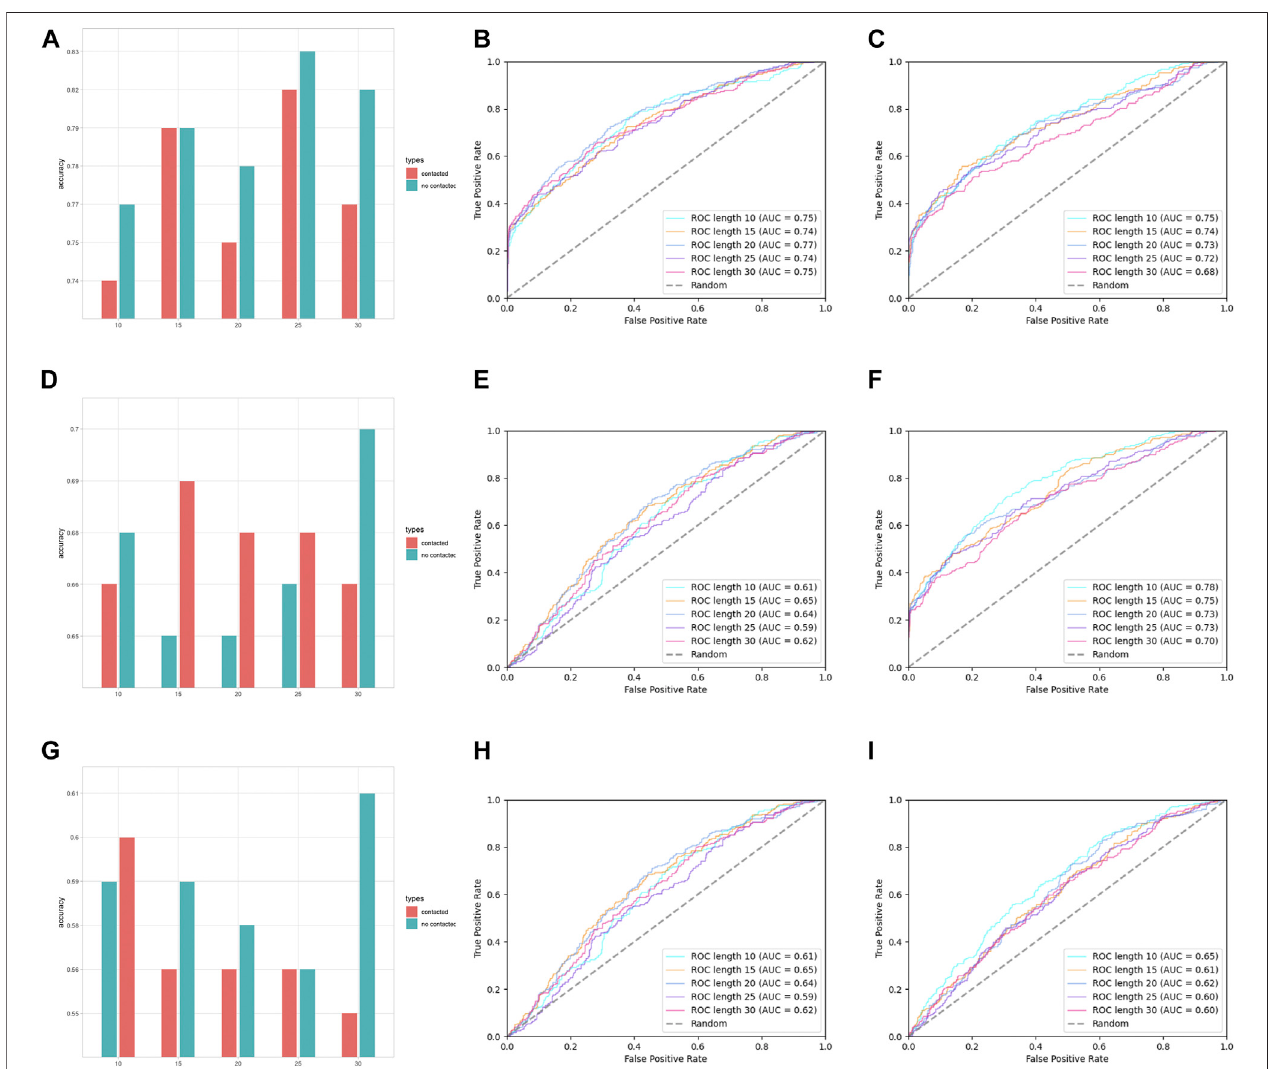
FIGURE 4 | Performance assessment of features AAC and RRC. (A) Group barchart of classi fi er SVM of features AAC and RRC; (B) ROC of feature AAC with classi fi er SVM; (C) ROC of feature RRC with classi fi er SVM; (D) group barchart of classi fi er RF of features AAC and RRC; (E) ROC of feature AAC with classi fi er RF; (F) ROC of feature RRC with classi fi er RF; (G) group barchart of classi fi er LR of features AAC and RRC; (H) ROC of feature AAC with classi fi er LR; (I) ROC of feature RRC withclassi fi erLR.In(a),(d),and(g),theredbarsrefertocontactedinformation,whichcorrespondstotheRRCfeature,whilegreenbarsrefertothecasecontaining no contacted residues, which corresponds to AAC